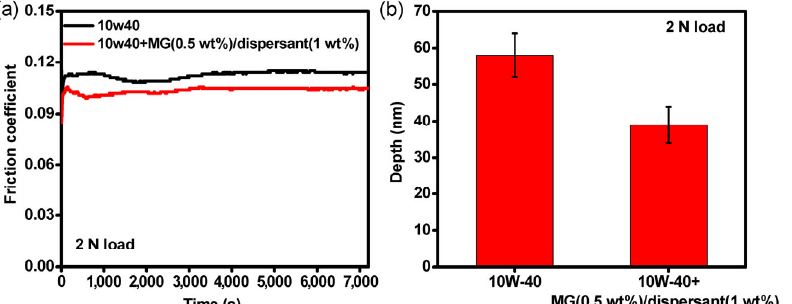
Fig. 5 (a) Friction coefficient curves of 10W-40 oil and 10W-40 oil with MG (0.5 wt%)/dispersant (1 wt%) and (b) corresponding depth of wear